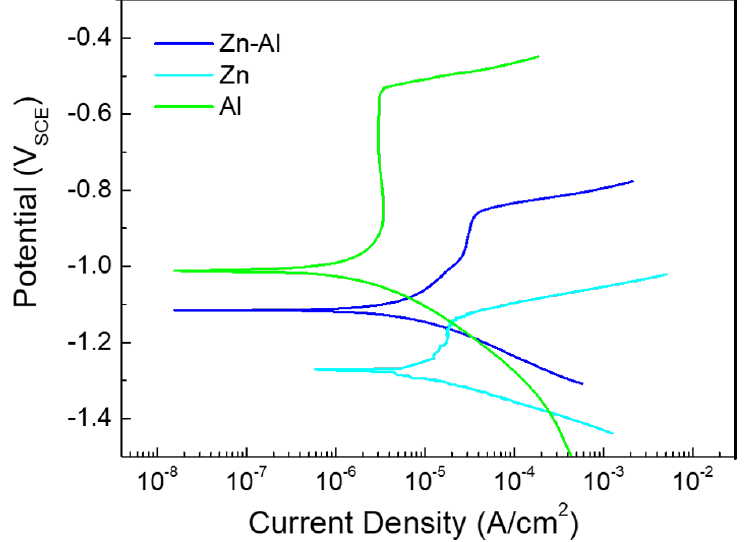
Figure 3. The potentiodynamic polarization curves of as-sprayed Zn–Al coating, Al coating and Zn coating. Table 2. Results of potentiodynamic polarization test in 3.5 wt.% NaCl solution.